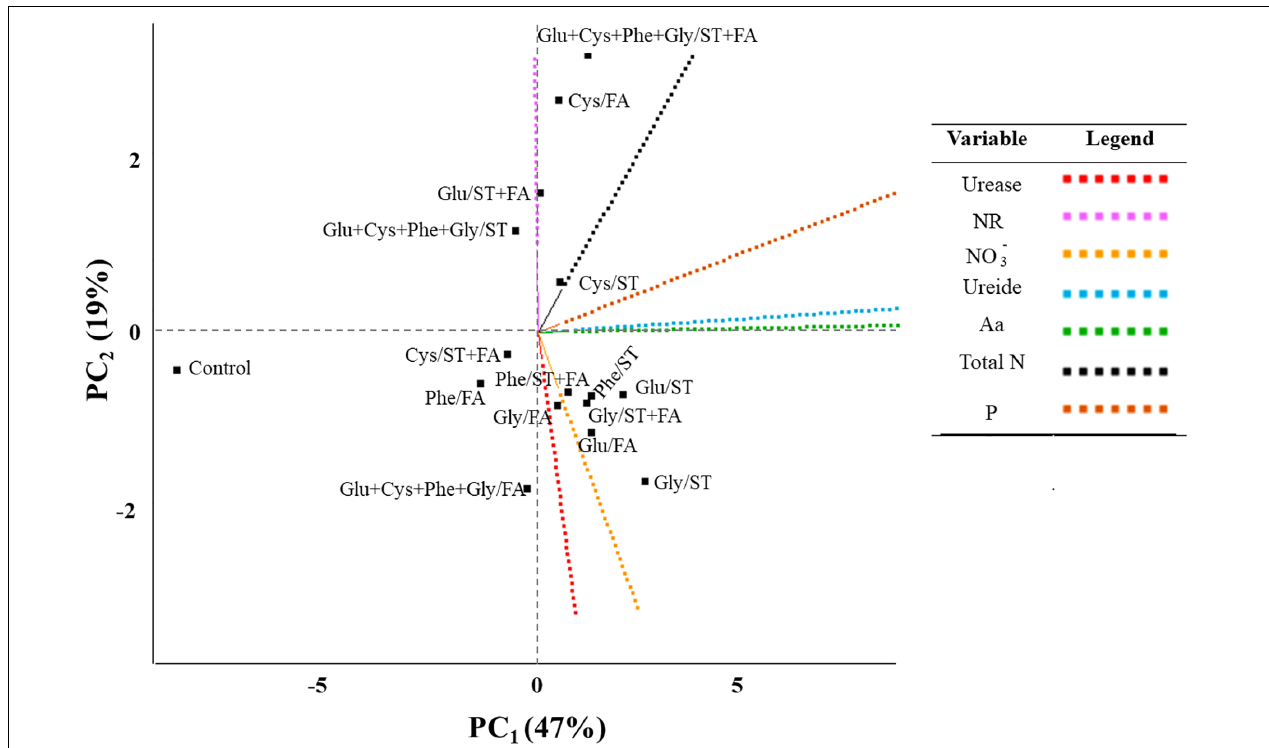
FIGURE 5 | Byplot obtained from the analysis of main components of the results of use of glutamate (Glu), cysteine (Cys), phenylalanine (Phe), glycine (Gly) and all these amino acids in association (Glu+Cys+Phe+Gly), as a function of seed treatment (ST) and/or foliar application (FA), on the soybean leaf activity of urease, NR 1 , nitrate reductase; NO 3 − , nitrate; ureide; Aa, total amino acids; and Total N, total nitrogen at V 6 stage; P, productivity. Field experiment. Season 2014/2015.